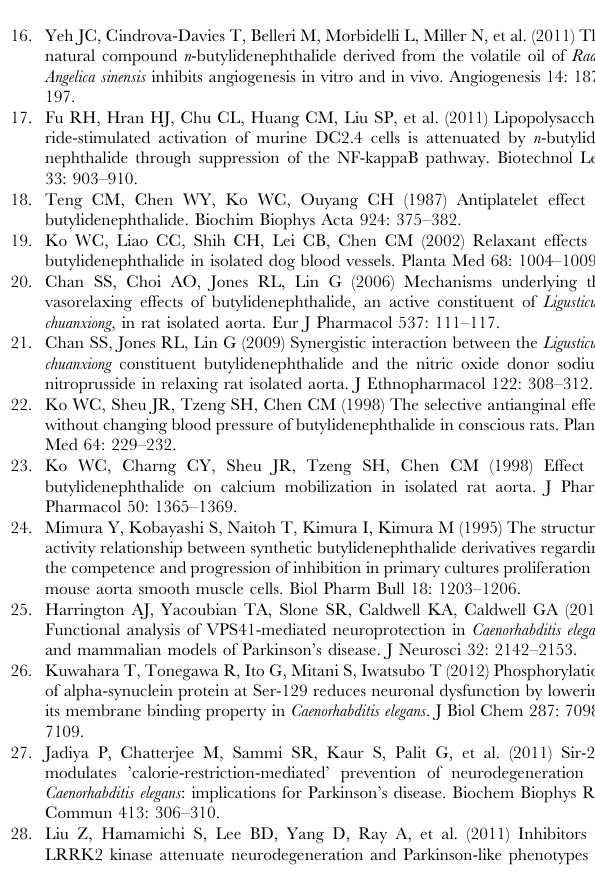
Table S1 List of primers used for qPCR